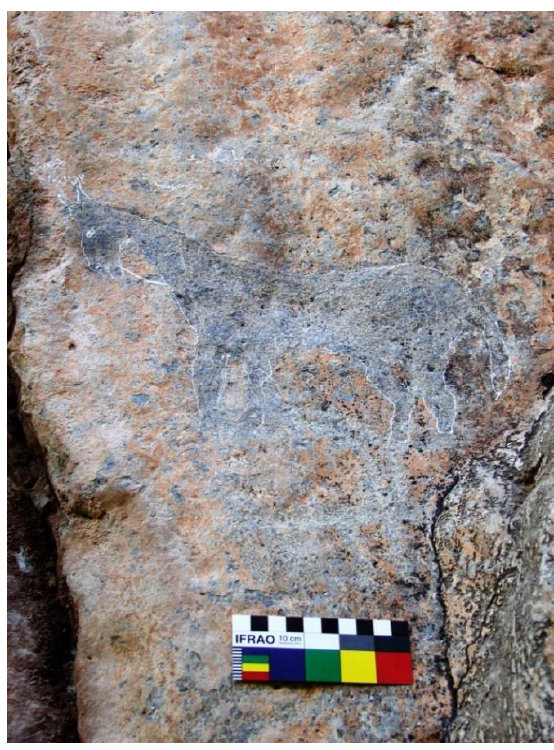
Figure 6. The image of an “ibex” and a “horse with harness” in